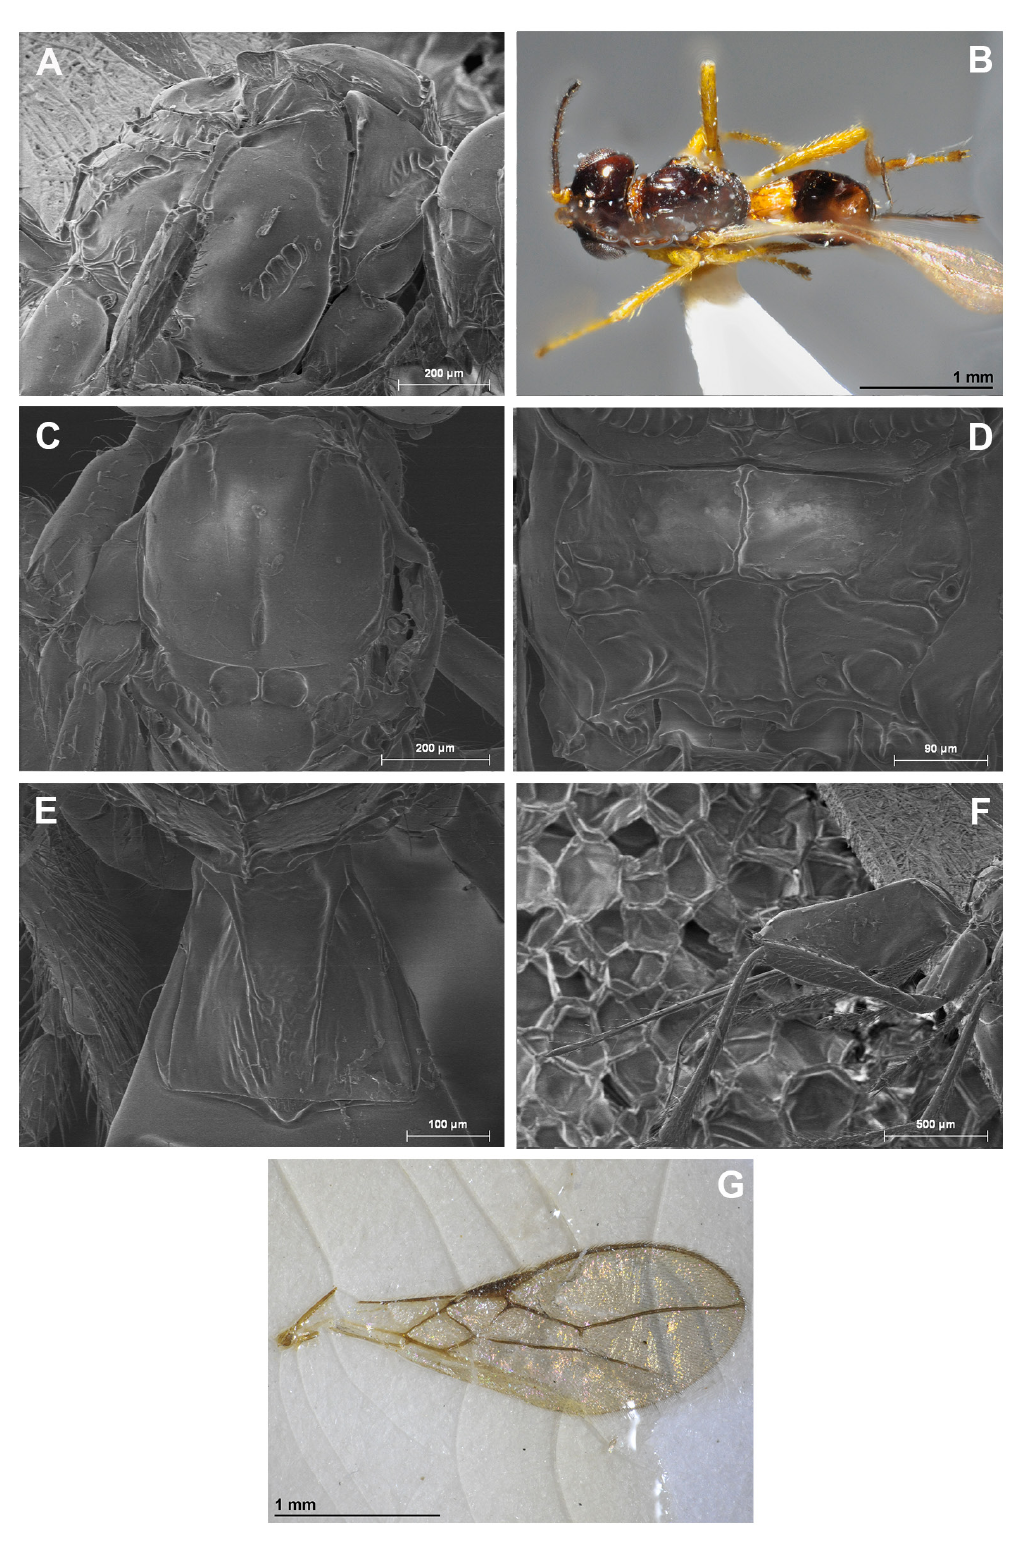
Fig. 26. Asobara kapiriensis Fischer, 2007, ♀, holotype (OLML). A . Mesosoma, lateral view. B . Habitus, dorsal view. C . Mesoscutum, dorsal view. D . Propodeum. E . First metasomal tergite, dorsal view. F . Hind leg, metasoma and ovipositor, lateral view. G . Fore and hind